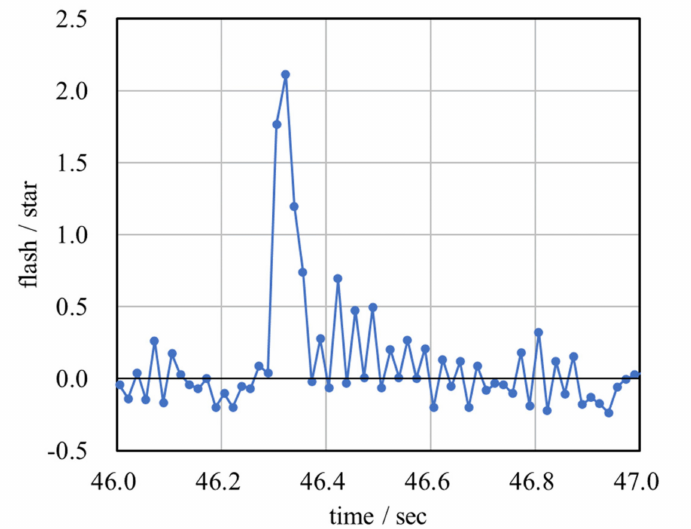
Figure 10. Light curve of Flash 1 as seen from Araruna, in brightness ratio of the flash to the comparison